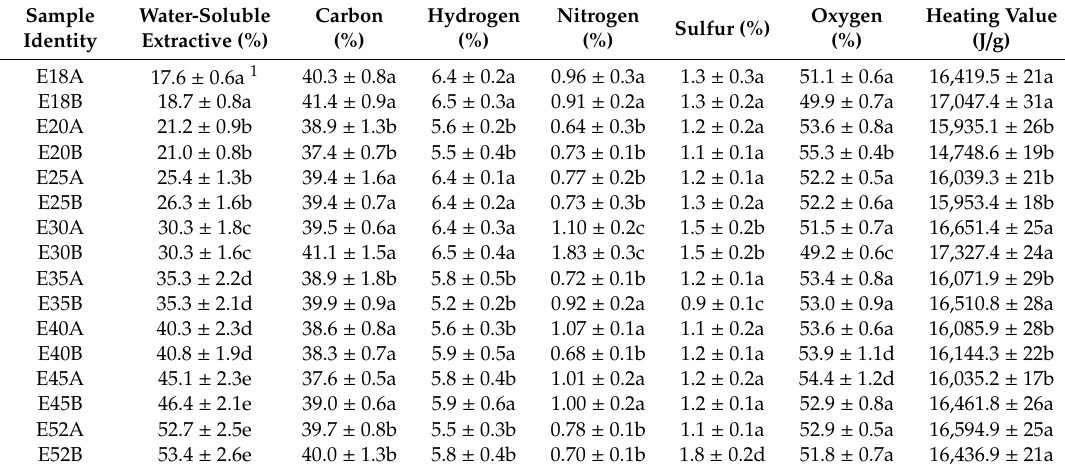
Table 1. Physico-chemical characteristics of sorghum